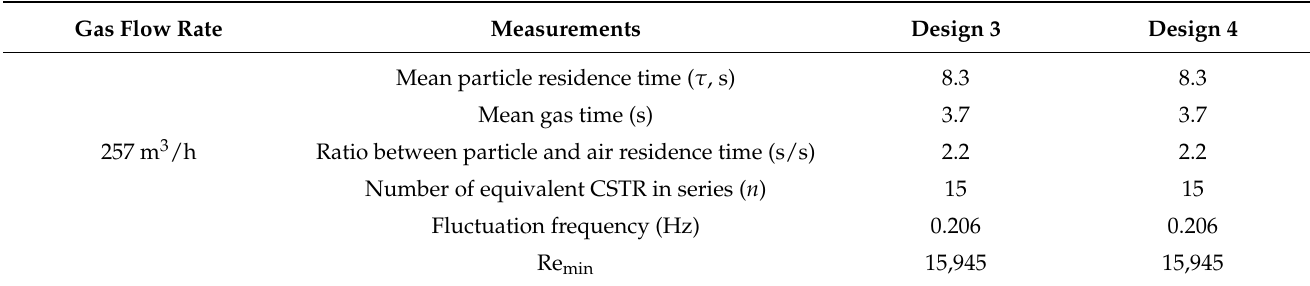
Table 4. RTD measurement result summary for experiments with salt